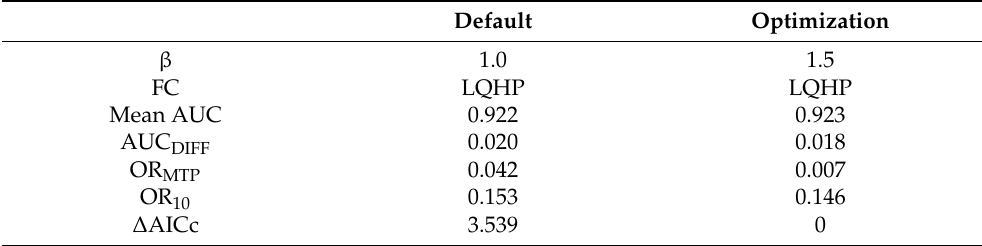
Table 2. Difference in performance of MaxEnt model under default and optimized